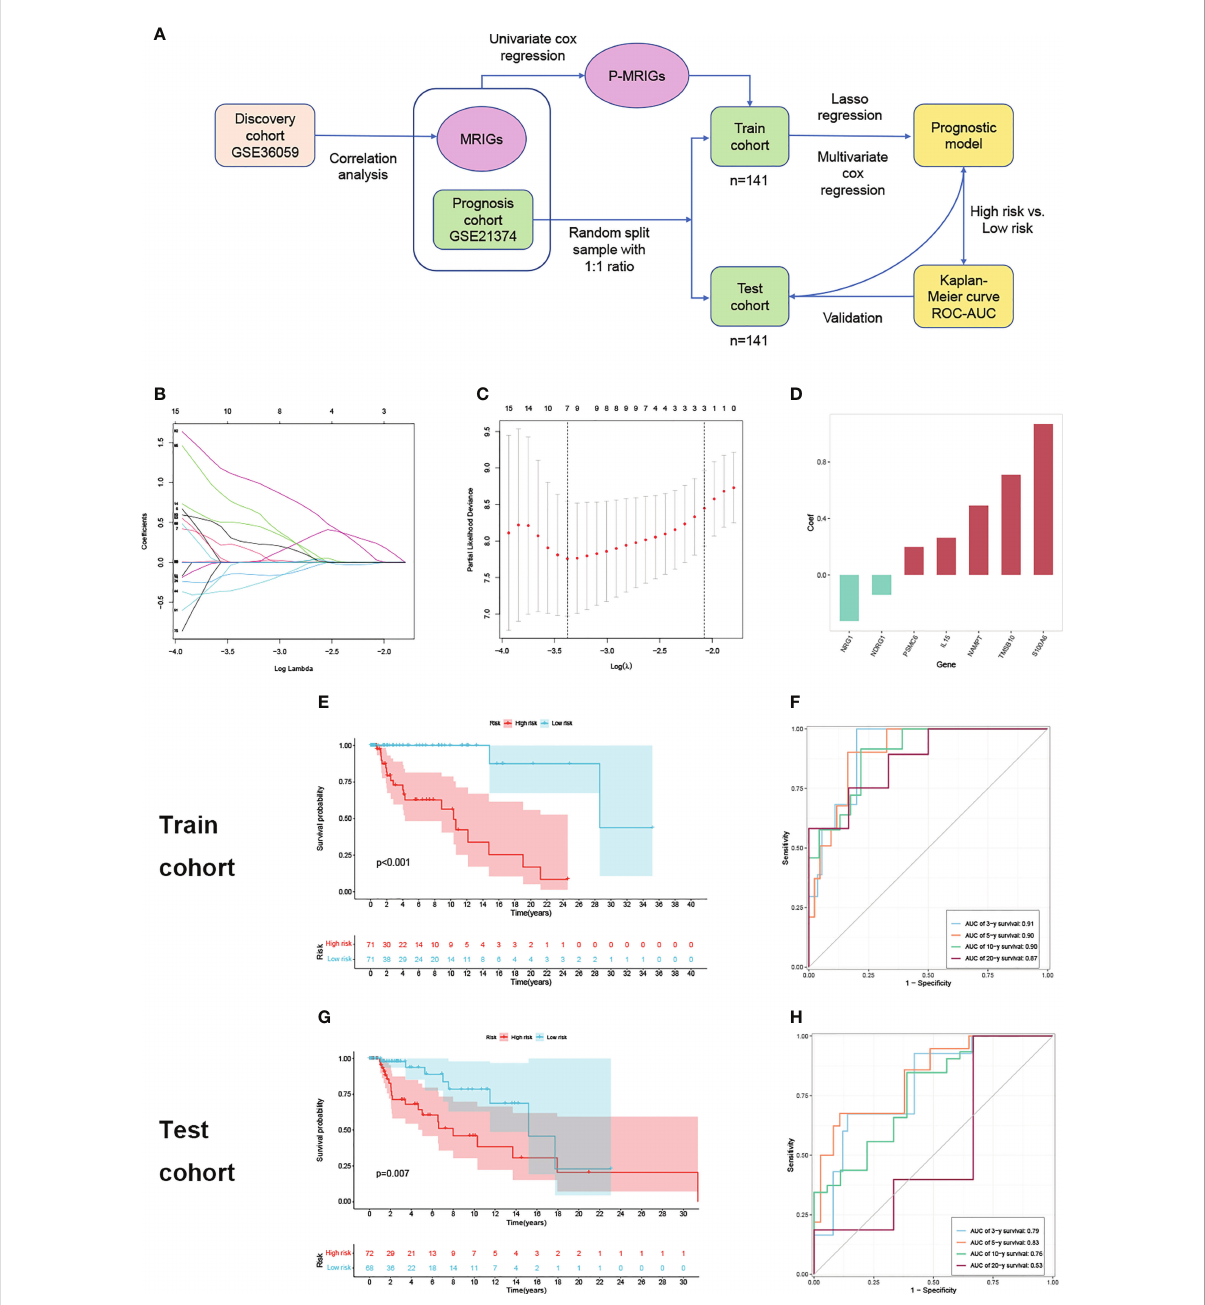
FIGURE 2 Construction and veri fi cation of prognostic prediction model. (A) Flow of constructing the prognostic prediction model. (B) Lasso coef fi cient pro fi les. (C) The partial likelihood deviance plot. (D) Coef fi cient of seven screened P-MRIGs in the prognostic prediction model. (E) The K-M curve showed that the high-risk group had a more inferior graft survival than the low-risk group in train set and (G) test set. (F) ROC curve of the model: the AUCs of 3-, 5-,10- and 20-year graft survival in the train set and (H) test set. Lasso, least absolute shrinkage and selection operator; P-MRIGs, prognostic m6A-related immune genes; K-M, Kaplan – Meier; ROC, receiver operating characteristic; AUC, areas under the